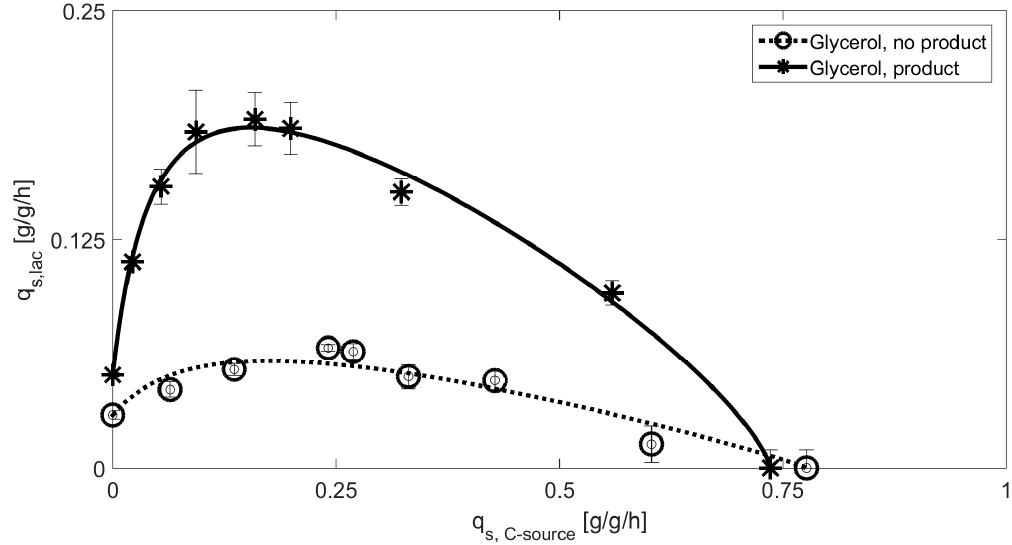
Figure 4. Extracted datapoints for q s,C values including standard deviations for cultivations with glycerol using the product producing (glycerol, product) and the NP strain (glycerol, no product). Solid lines represent the model based approach for inducer uptake rates vs. feeding rates models of glucose.